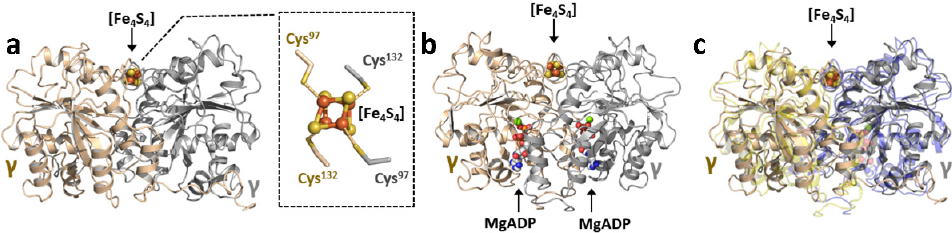
Figure 3. The structural impact of MgADP binding on NifH. Crystal structures of ( a ) nucleotide- free (PDB entry 2nip) and ( b ) MgADP-bound forms of NifH (PDB entry 6n4l); and ( c ) an overlay of the structures of nucleotide-free and MgADP-bound NifH, showing little change in the overall conformation of NifH upon nucleotide binding. The ligands coordinating the [Fe 4 S 4 ] cluster of NifH are shown as sticks in the inset ( a ). The subunits, clusters, and MgADP are presented and colored as those in Figure 1.